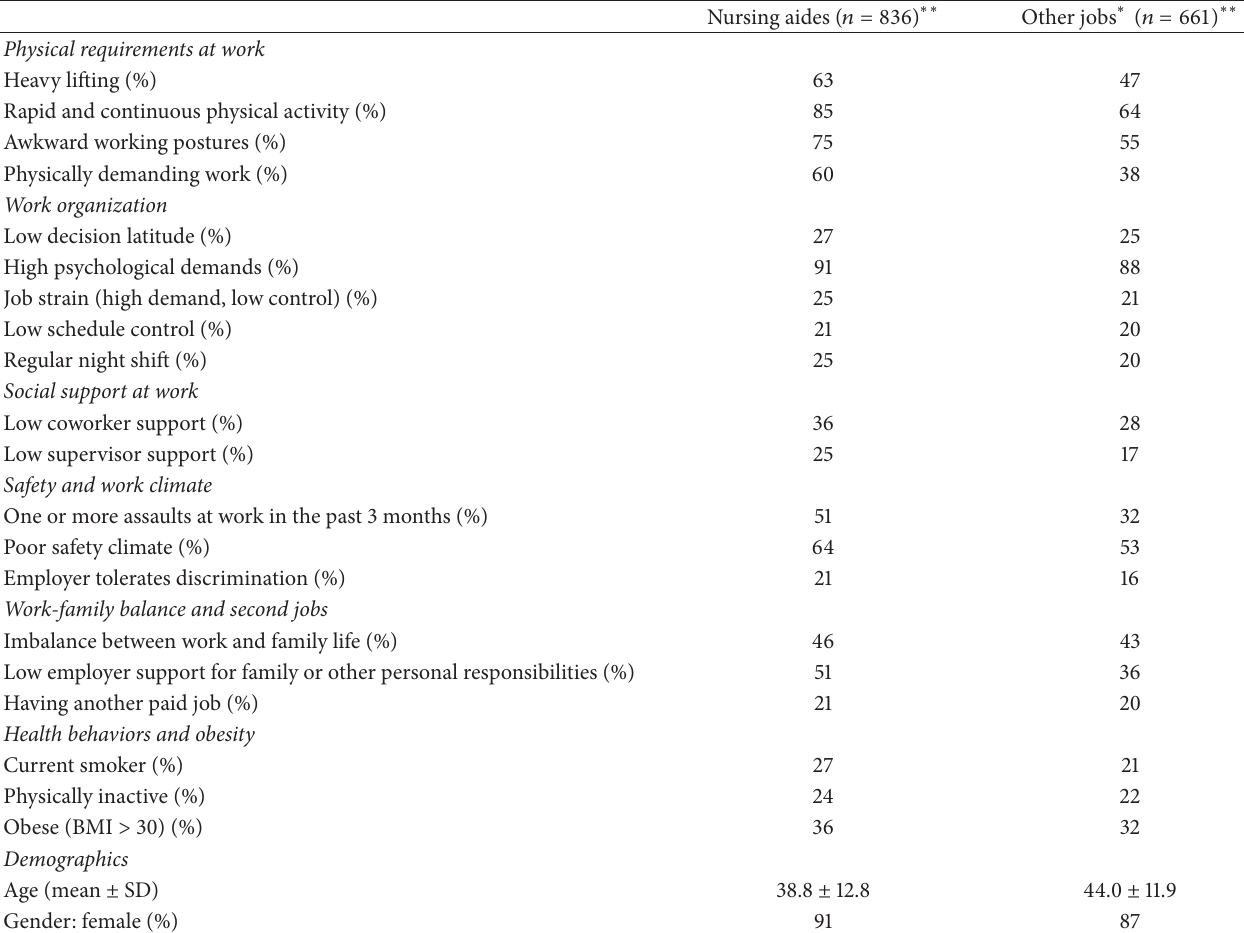
Table 1: Self-reported working conditions and personal factors, by job title: 1,506 U.S. nursing home